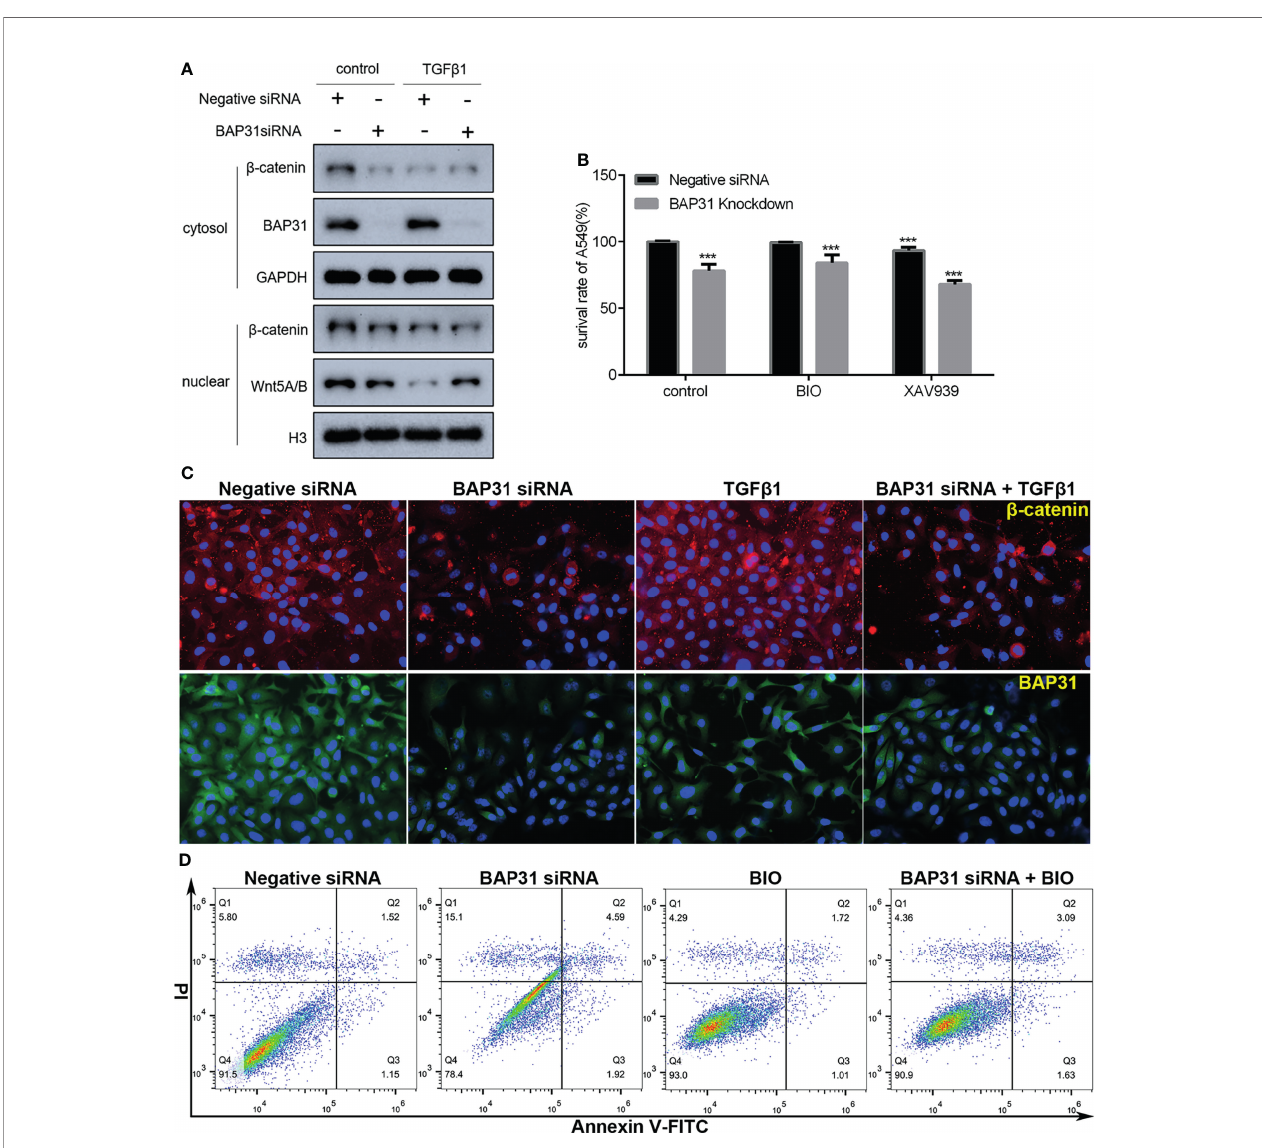
FIGURE 8 | Investigation on the role of Wnt/ b -catenin signaling in the A549 lung cancer cells. (A) Expression of nuclear b -catenin as evaluated by Western blot. (B) The survival of lung cancer cells was examined by the CCK-8 assay. The BAP31 siRNA knockdown cells received combinatorial treatment with BIO or XAV939. *** p < 0.001 versus negative siRNA in control group. (C) Distribution of b -catenin (red) and BAP31 (green) as determined by immuno fl uorescence. Nuclei were stained with Hoechst 33342 (blue). (D) Apoptosis was determined by annexin V-FITC/PI staining using fl ow